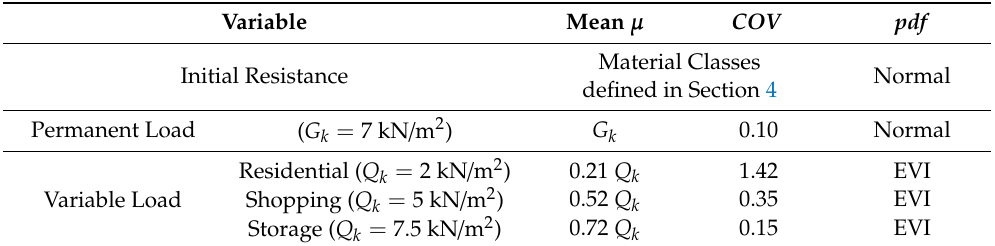
Table 3. Statistical description of structural resistance and